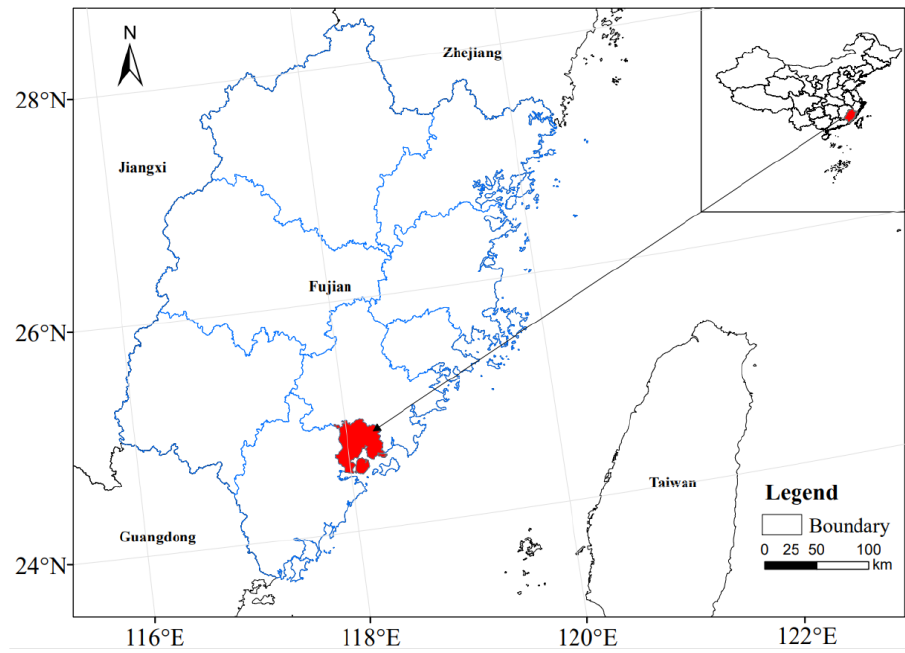
Figure 1. Location of the study area.